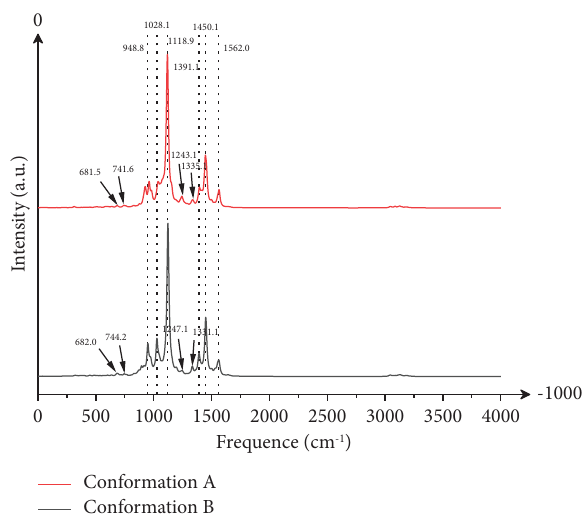
Figure 3: Teoretical vibration spectra of two diferent conformations of ICG